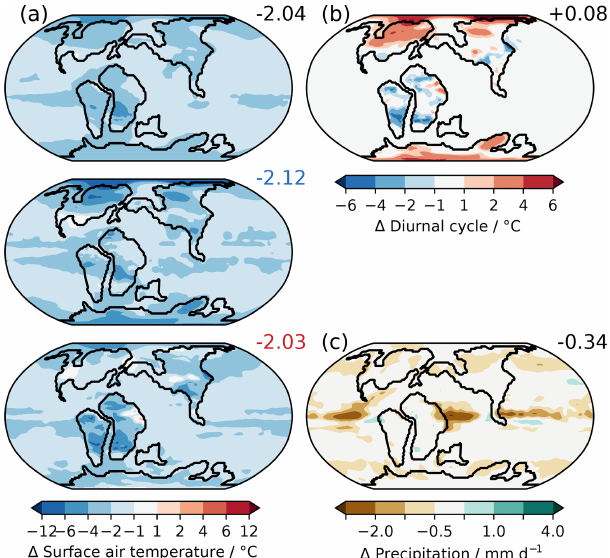
Figure 15. The 21%–10% O 2 anomalies for Poulsen et al. (2015) simulations. (a) Annual-mean, cold-month mean and warm-month mean surface air temperature difference. (b) Change to diurnal cycle and (c) annual-mean precipitation (mmd − 1 ).